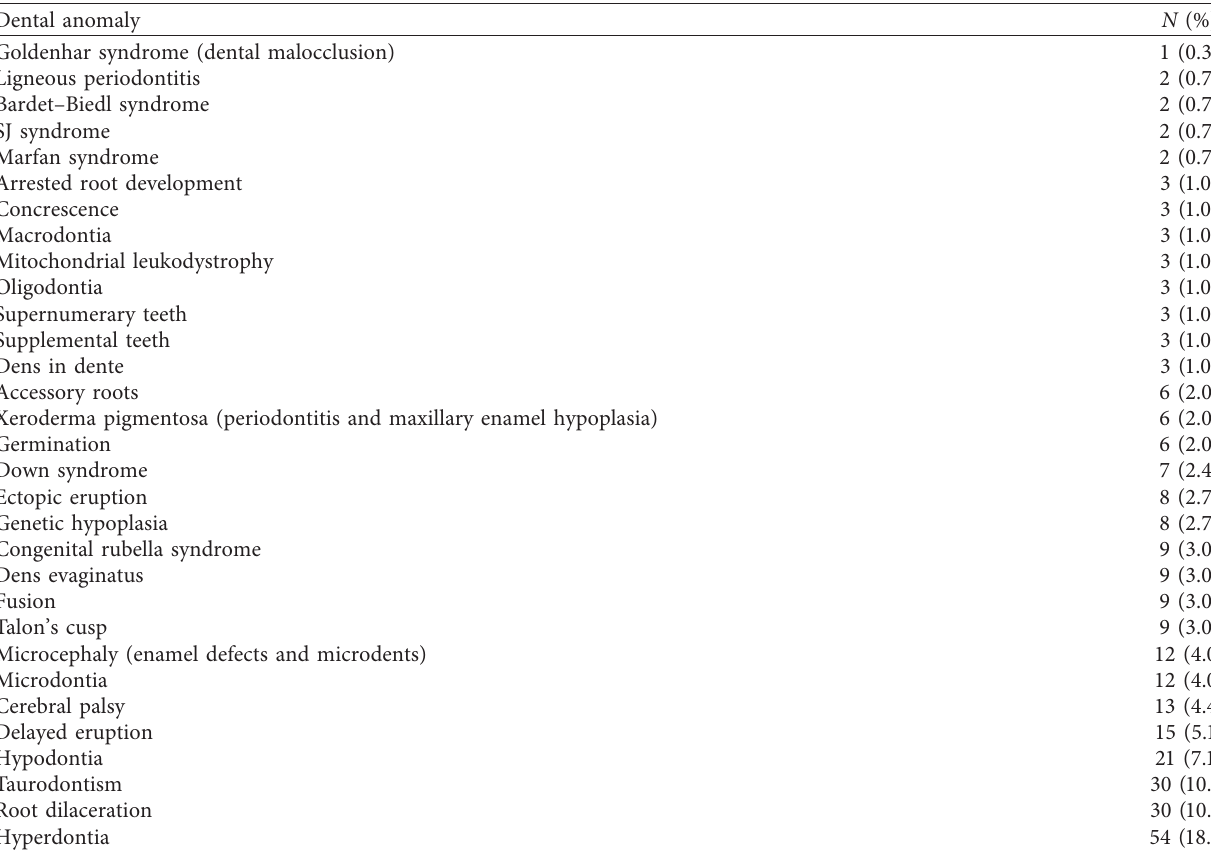
Table 1: Association of consanguineous marriages and dental anomalies.